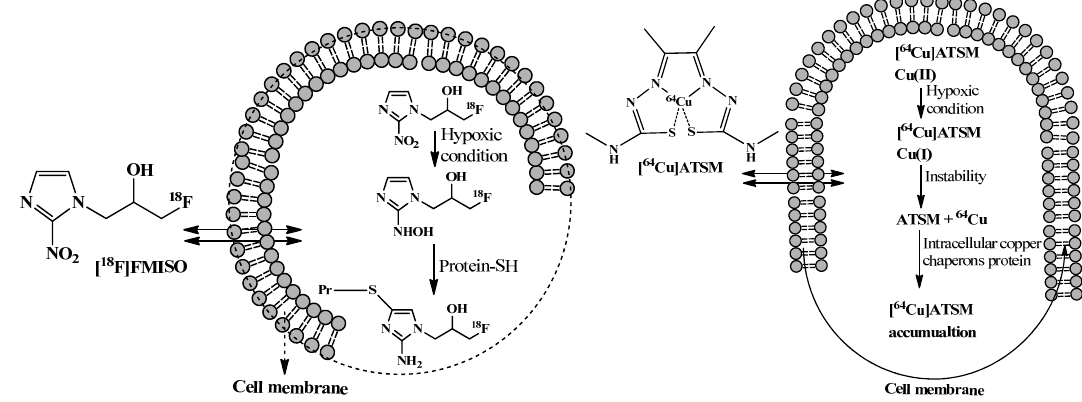
Figure 3. Different radiopharmaceuticals for measuring hypoxia. FMISO is believed to bind cova- lently to macromolecules in hypoxic cells after reduction of its nitro group [51]. In a hypoxic condition, the Cu(II)-ATSM (oxidation level of copper-64 is +II) is reduced to Cu(I)-ATSM (oxidation level of copper-64 is +I) then the complex becomes unstable and free copper-64 is trapped and accumulated in intracellular copper chaperone proteins [52] .